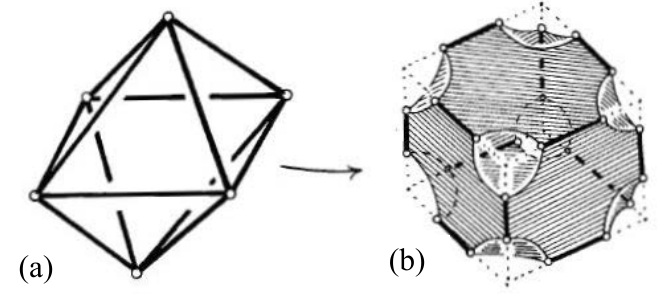
Figure 36. Polarity takes the octahedral bar–joint framework ( a ) to the cubic sheetwork ( b ) [114]. Recall from Example 11 that the pure condition for the octahedron is that four opposite faces meet in a point. Under polarity, this condition must become that the four opposite vertices of the sheetwork cube are coplanar. If one set of four opposite vertices is coplanar, then the other four vertices must also be